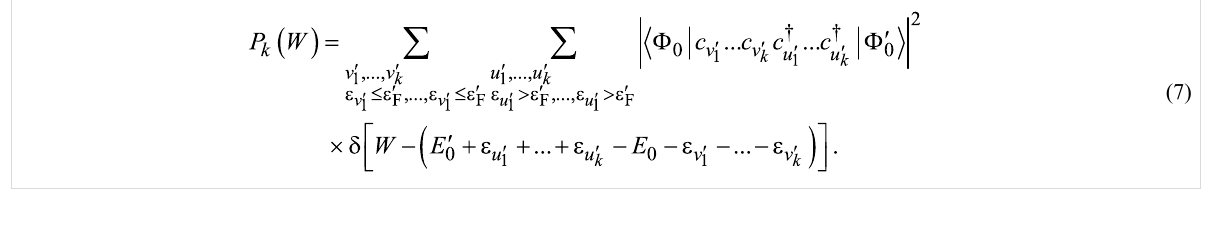
Table 3: Ground-state survival probability and shake-up probabilities involving excited states with 1–3 particles above the Fermi level. The closure relation , projected onto the unperturbed ground state, is verified with an error of less than 5% in all